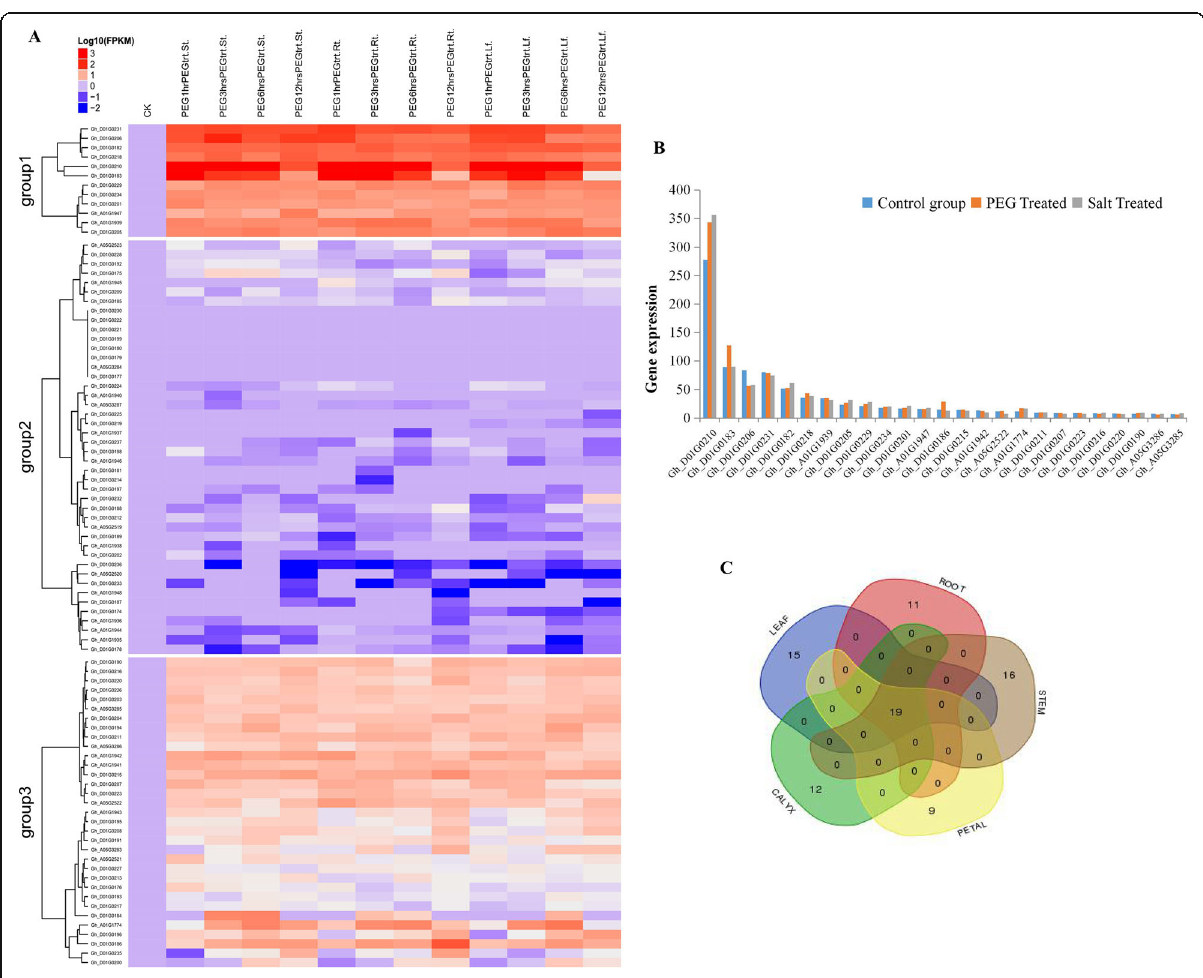
Fig. 6 RNA seq. expression profile of the mined genes under drought stress condition. a Mined genes RNA seq. expression profile root, leaf and stem tissues under drought stress. b Differential expression of the selected genes compared to control and c Venn diagram illustrating the distribution of the genes in five different plant organs. The RNA seq. expressions are expressed as log10 of RPKM. Abbreviations: St: stem, Rt: root, Lf: leaf, Trt: treated and PEG: polyethylene glycol-6